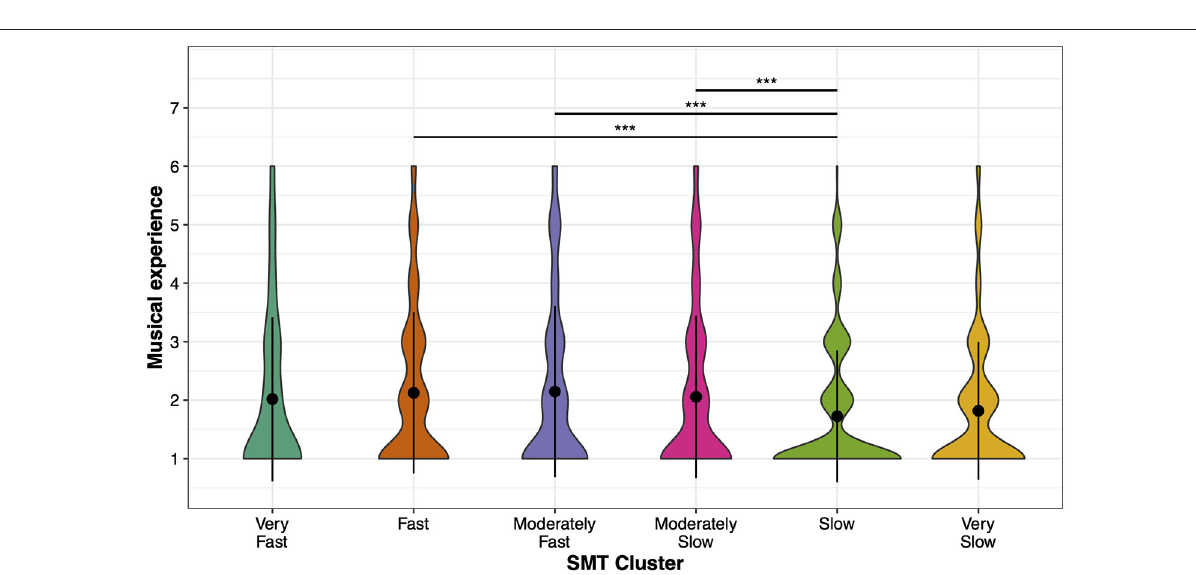
0.004, with Arousal ( β = − 0.05, p = 0.001) and